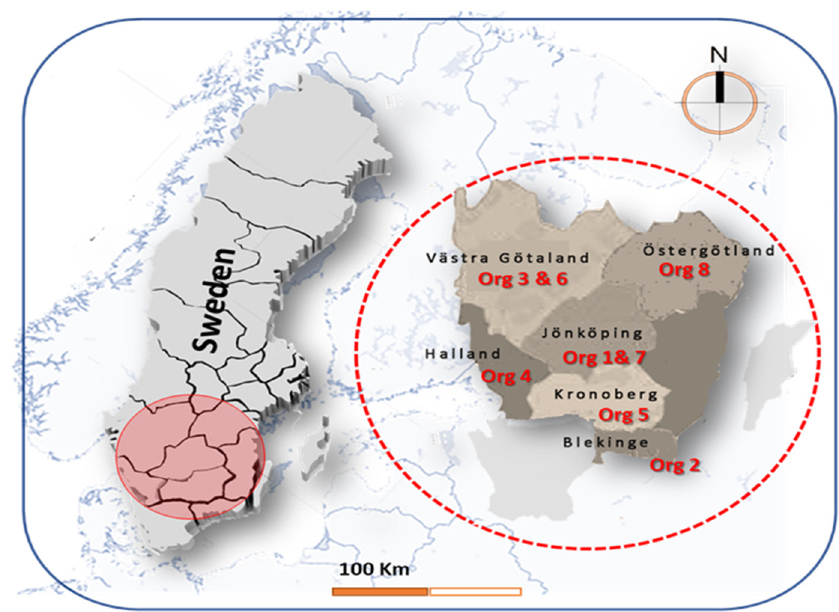
Figure 6. Map of Sweden and the studied organizations (Orgs 1–8) within the six